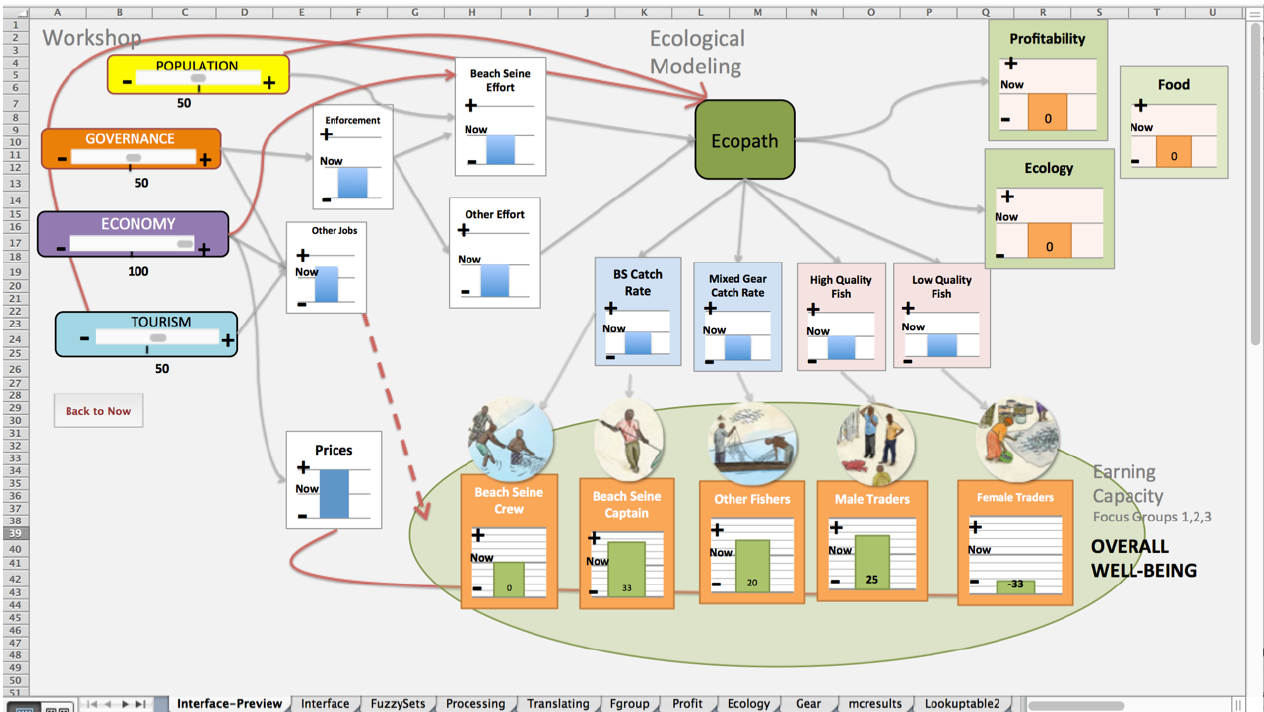
Fig. 3 . Toy-model interface in Microsoft Excel®. The user can interact with the following parameters: Population, Governance, Economy, Tourism, and they can visualize how they dynamically affect fishing effort (beach seine effort and other effort), which in turn changes the ecological status and affect five different stakeholder groups in different ways. Also three management objectives (Profitability, Food, and Ecology) are shown. Detailed description in Appendix 1 and the Excel model is available at